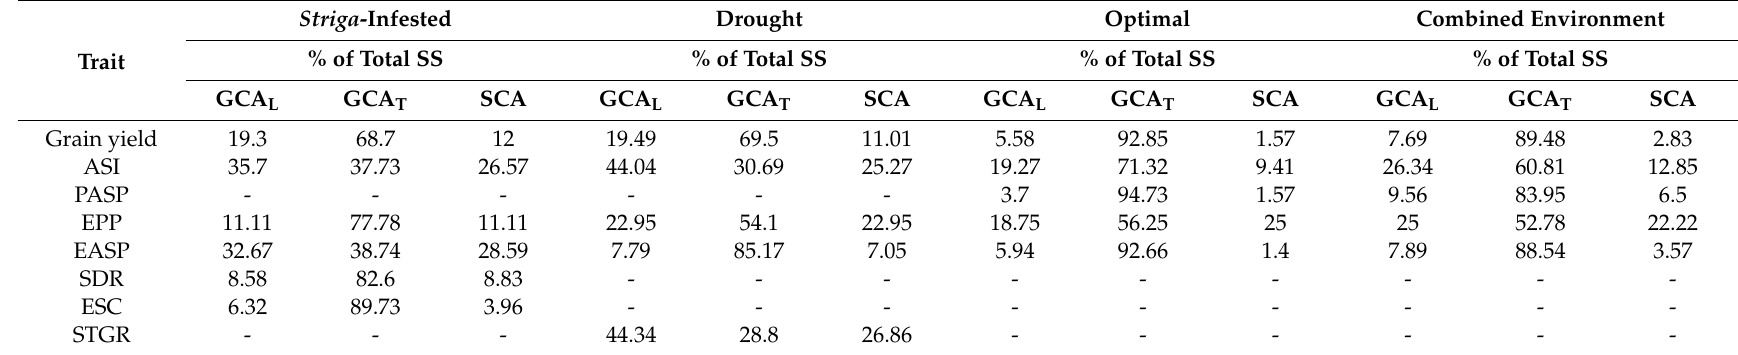
Table 5. Percentage of GCAs and SCA sums of squares (SS) to total genotypic SS of grain yield and other agronomic traits of maize hybrids under Striga -infested, drought, optimal, and combined environments.